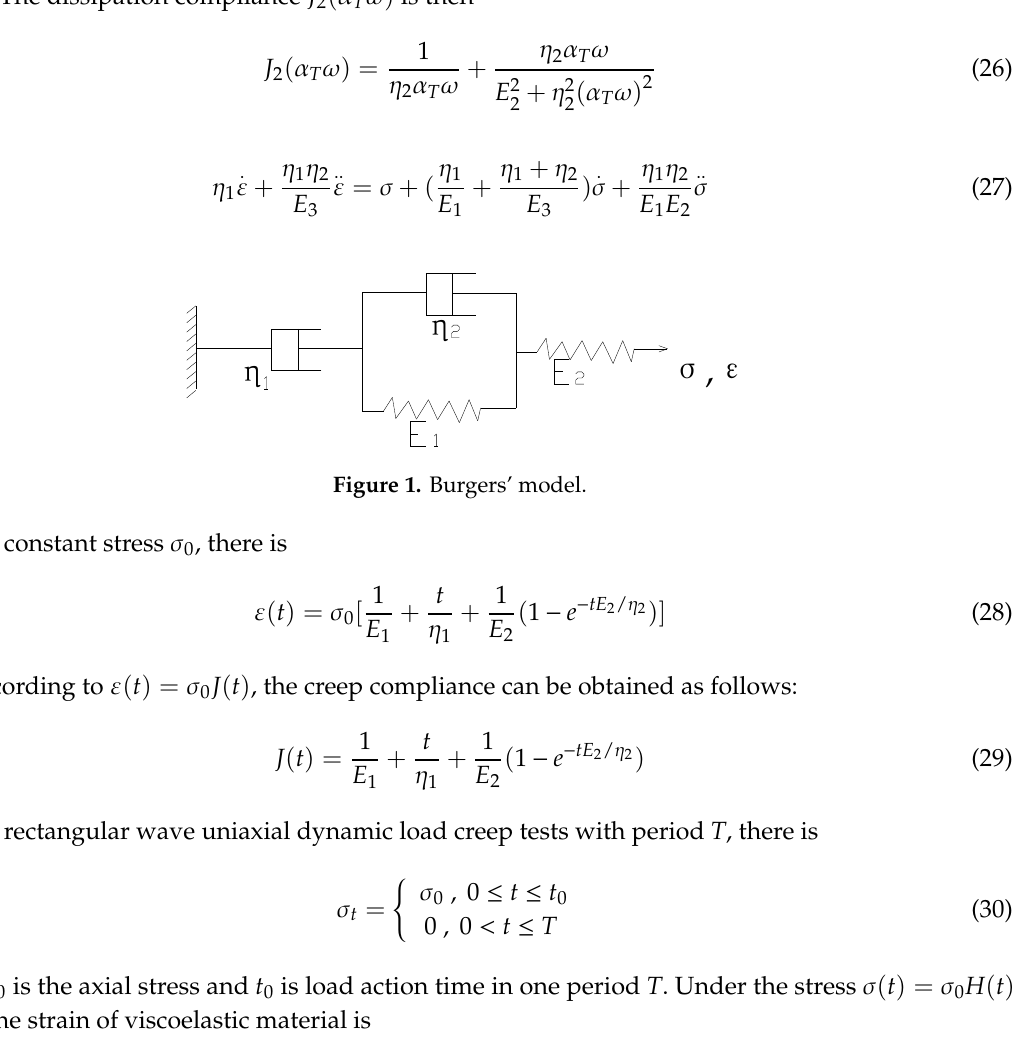
Figure 8. Prediction and test results of fatigue life for asphalt mixture. 02,0004,0006,000 8,000